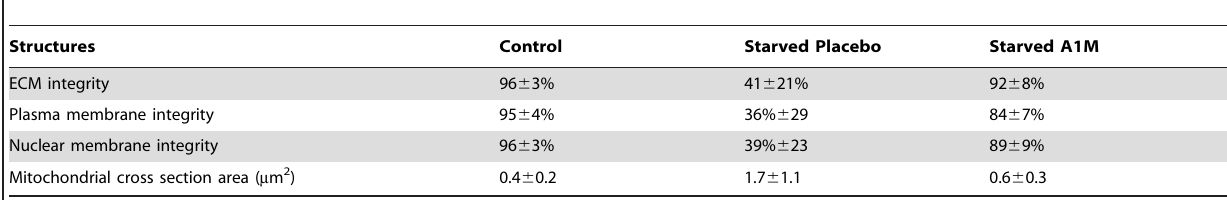
Table 2. Quantification of values for the surface areas obtained by transmission electron microscopy of the kidney tissue samples.